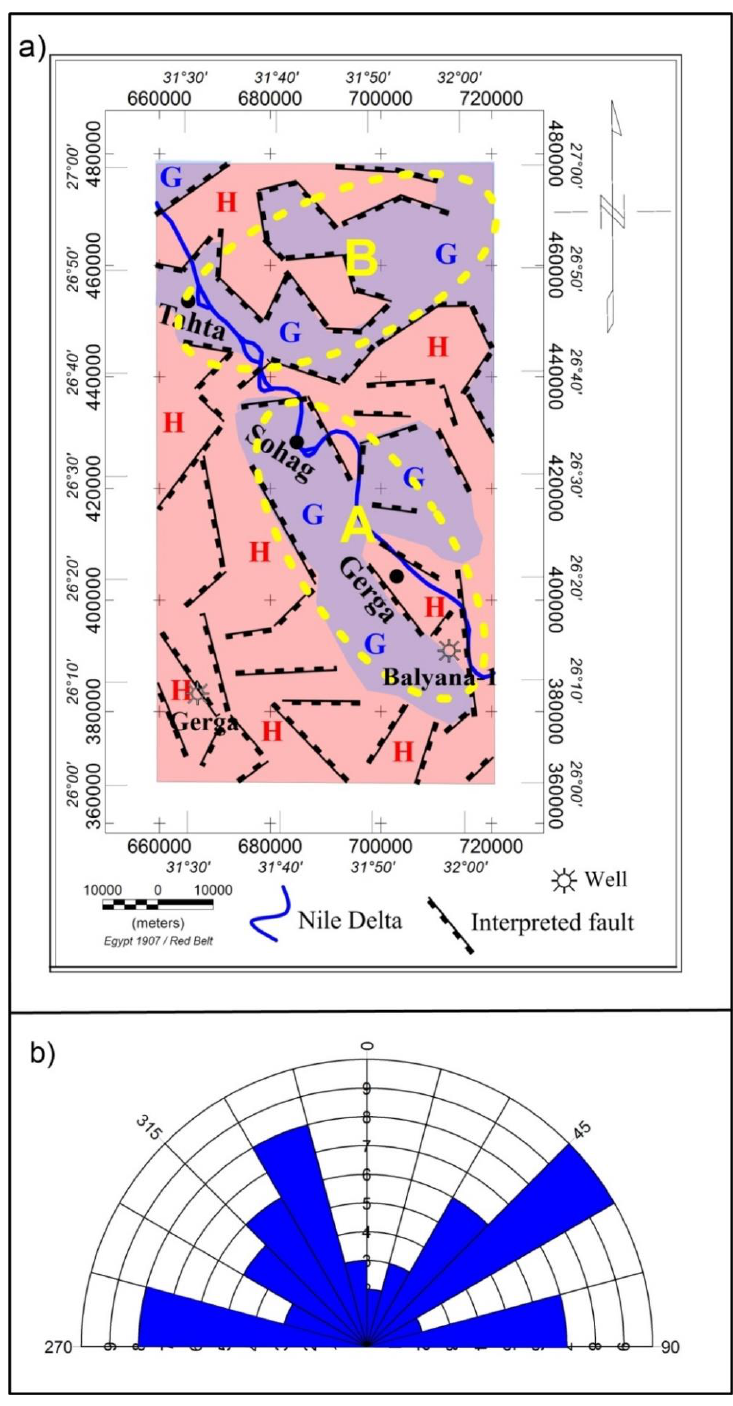
Figure 7. Deduced structural map ( a ) and its rose diagram ( b ). H refers to horst or basement uplift and G refers to graben. G refers to